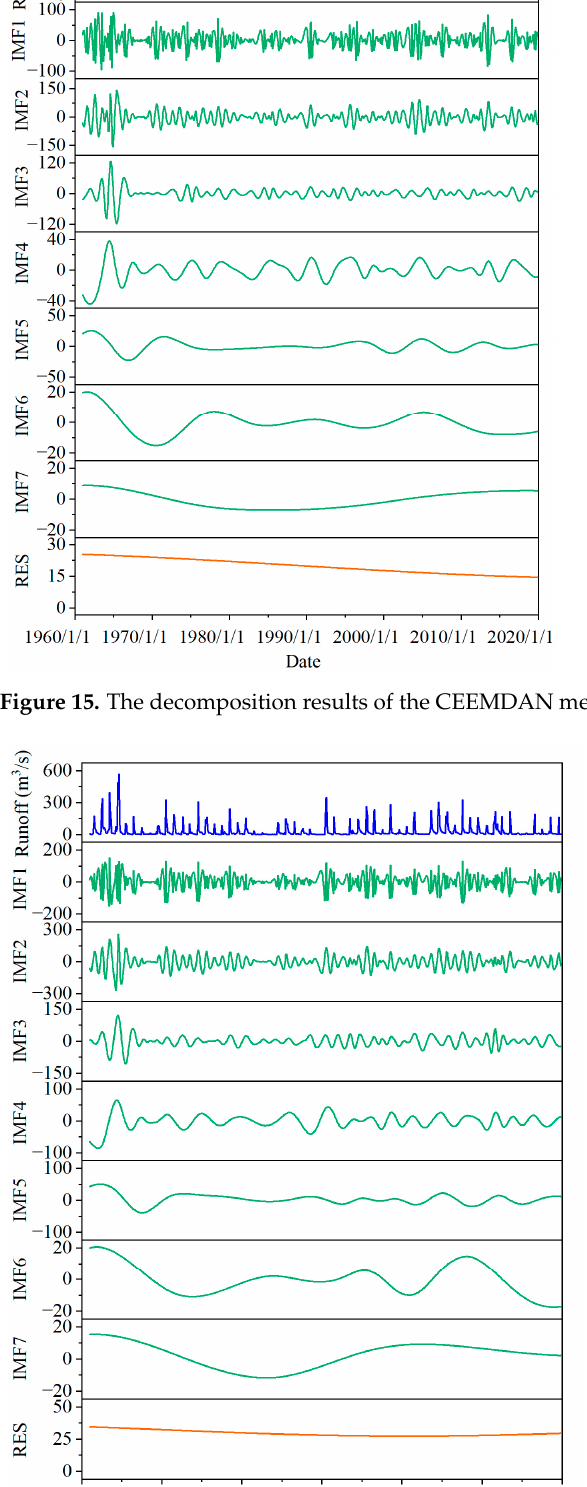
Figure 16. The decomposition results of the CEEMDAN method for runoff at Dawenkou station